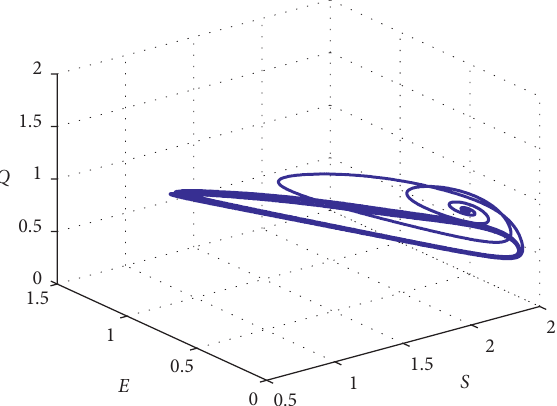
Figure 3: Scatter